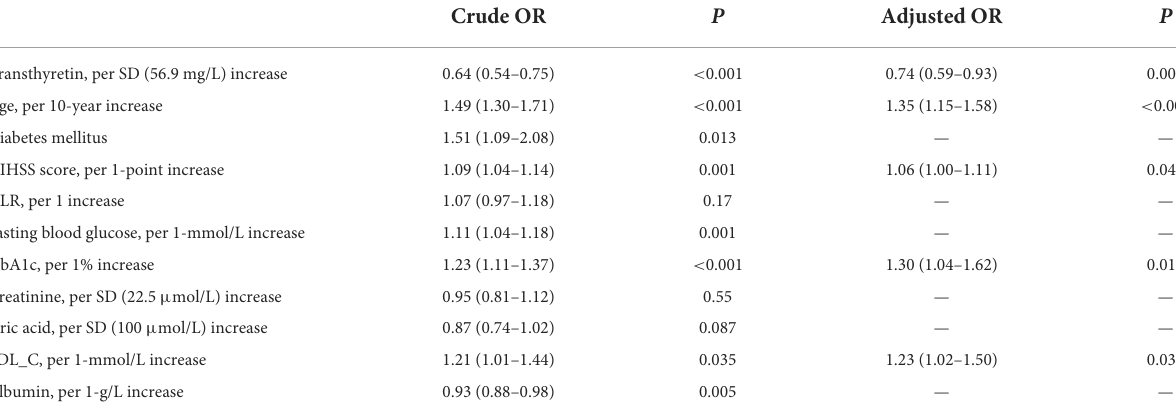
TABLE 4 Multiple logistic regression analysis to identify independent associated factors with ICAS. Crude OR P Adjusted